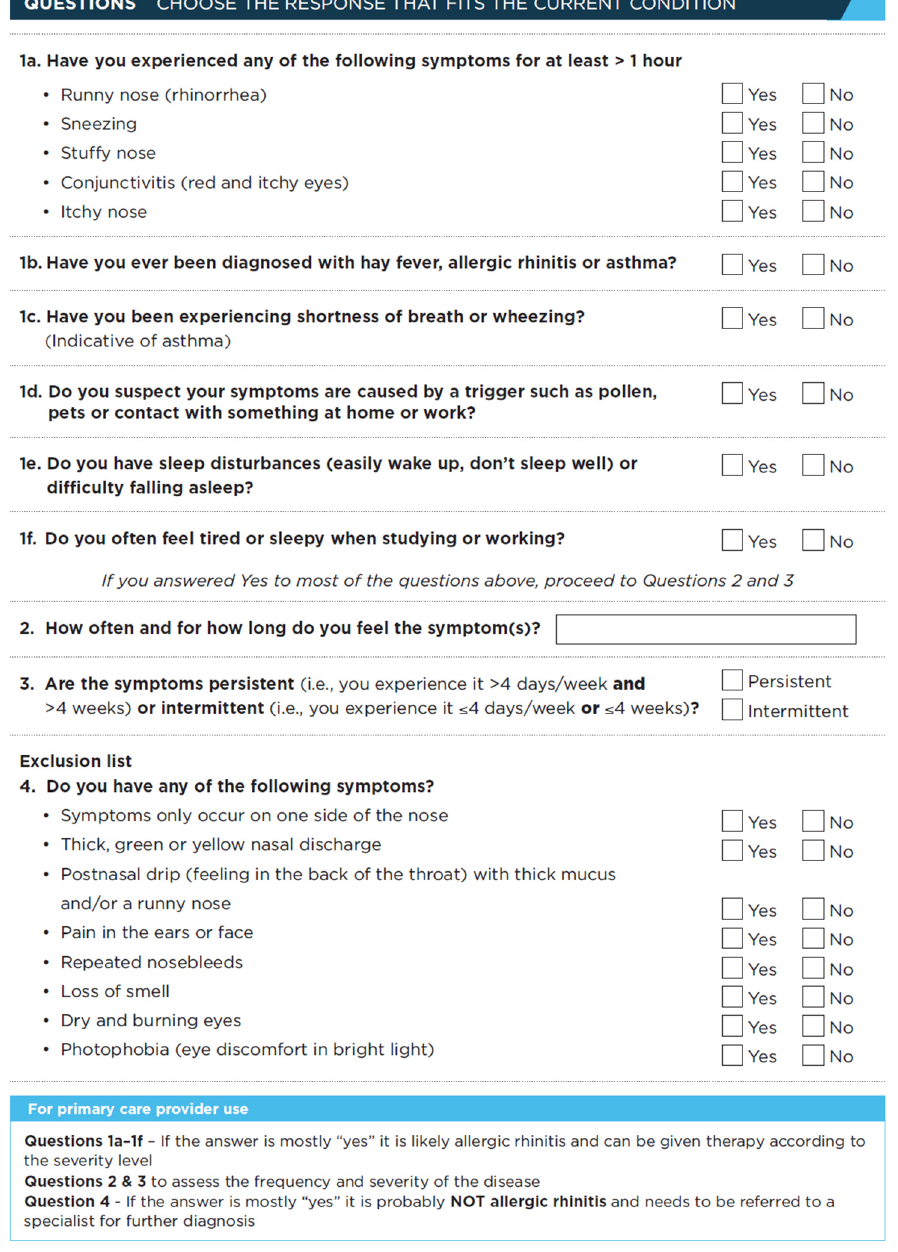
Figure 2. Screening patients for symptoms of allergic rhinitis.